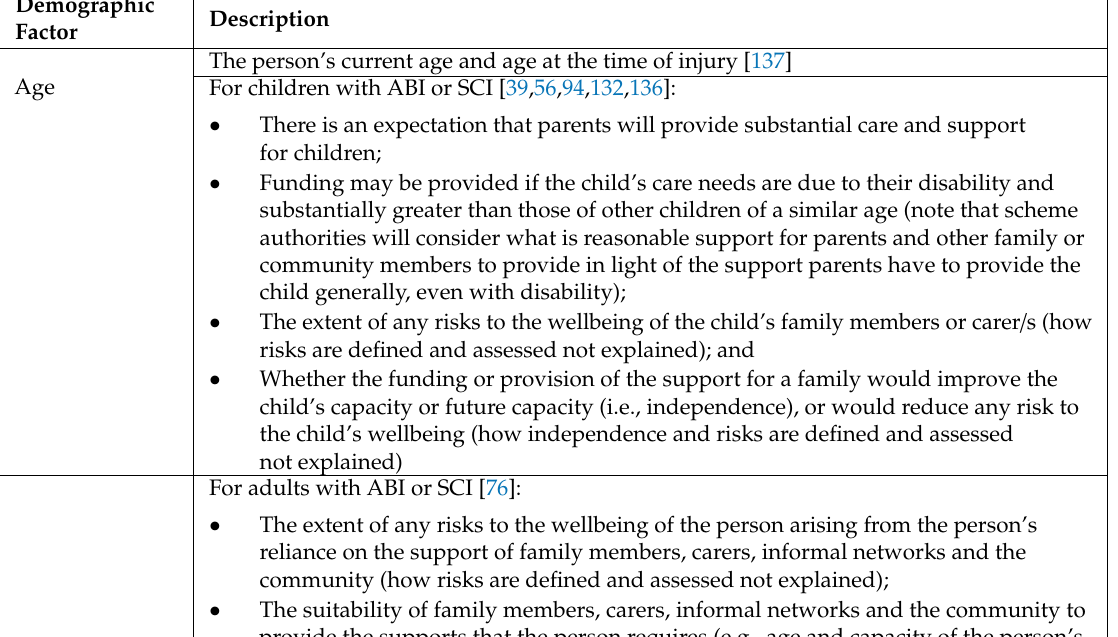
Table 5. Summary of Demographic Factors That Influenced the Provision of Housing-Related Funding. Demographic Factor